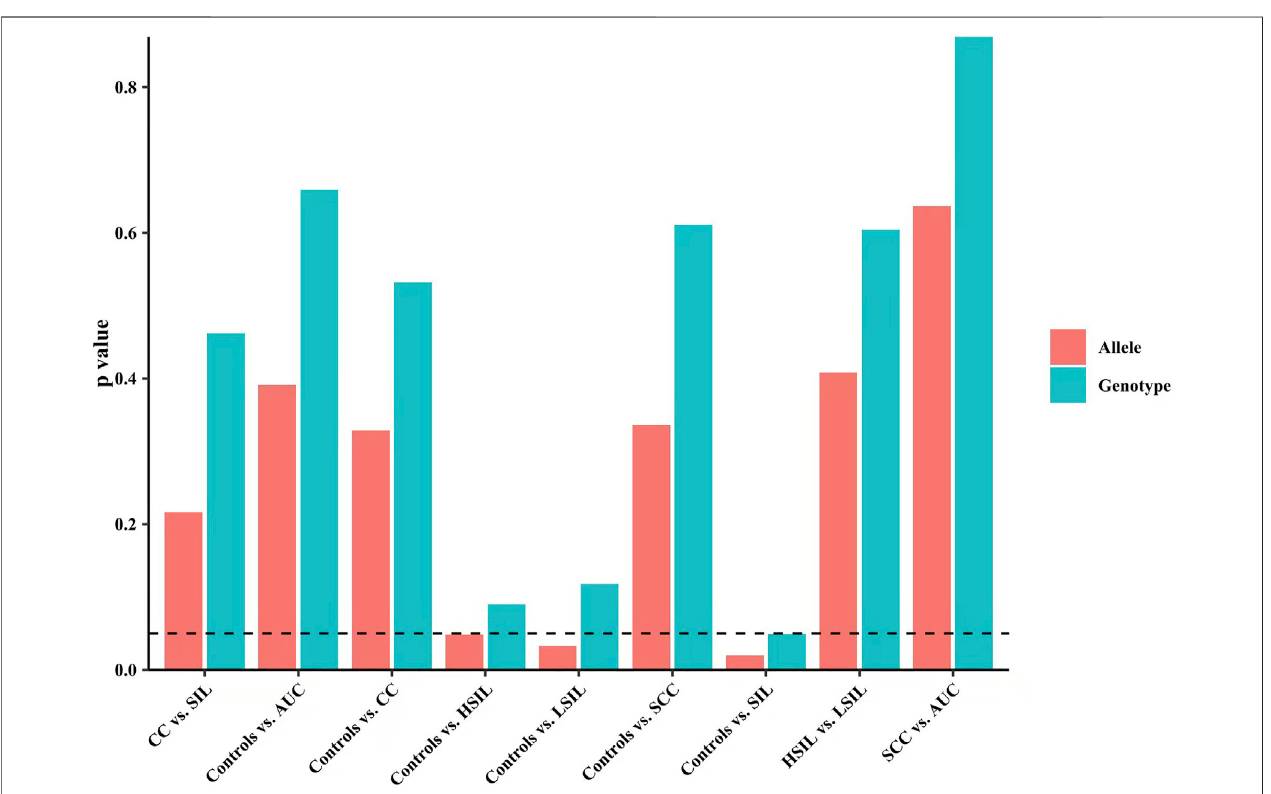
FIGURE 1 | Results of chi-square tests show the comparison of genotypes and allele distribution frequencies between groups.